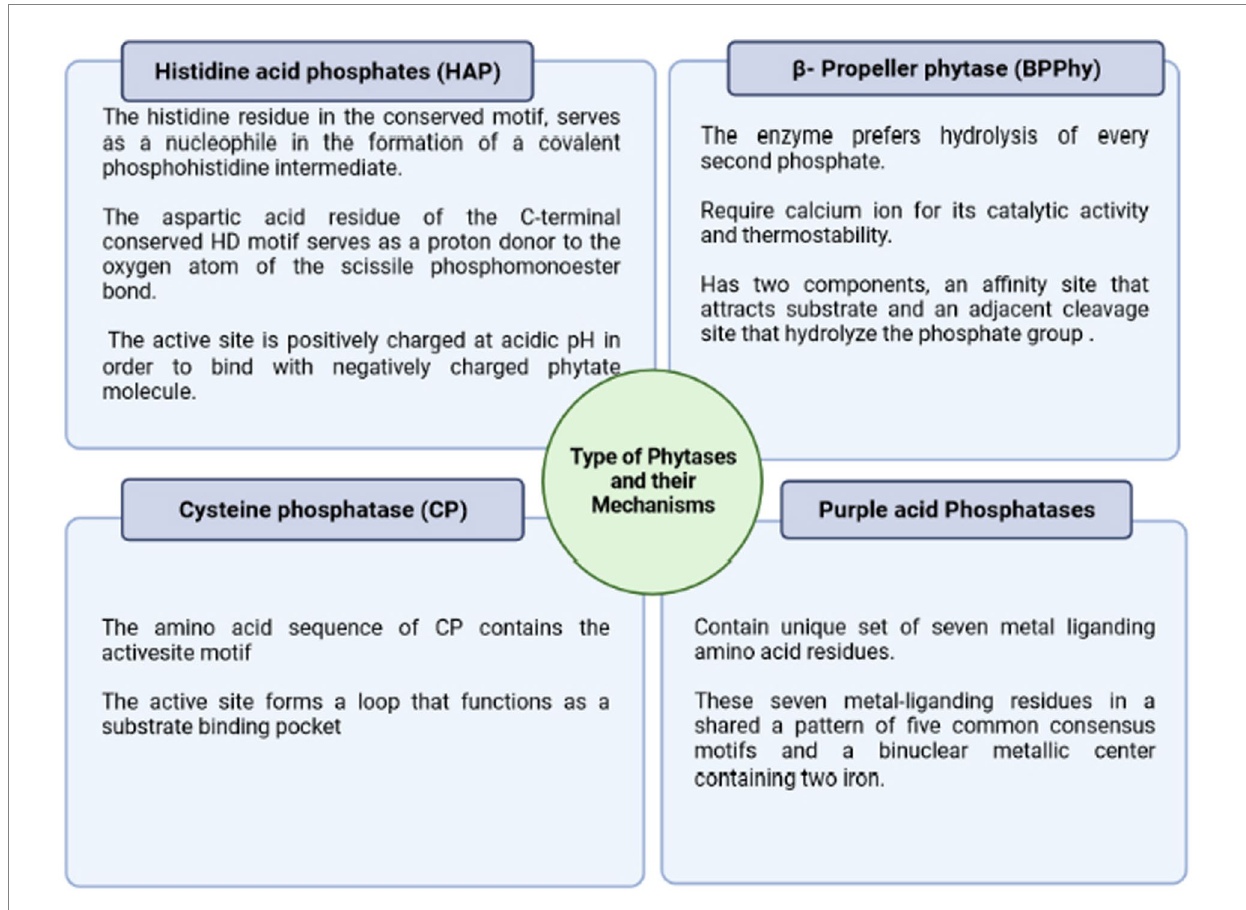
FIGURE 3 Major types of phytases and their different mechanism of action stating a basic criterion for their